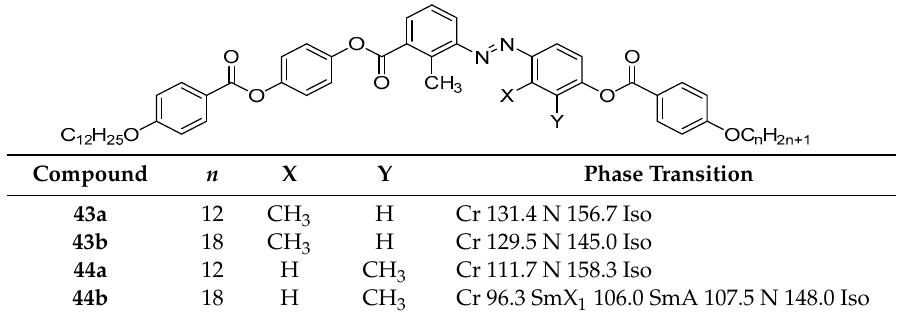
Table 9. Phase transition of compounds 43 and 44 .